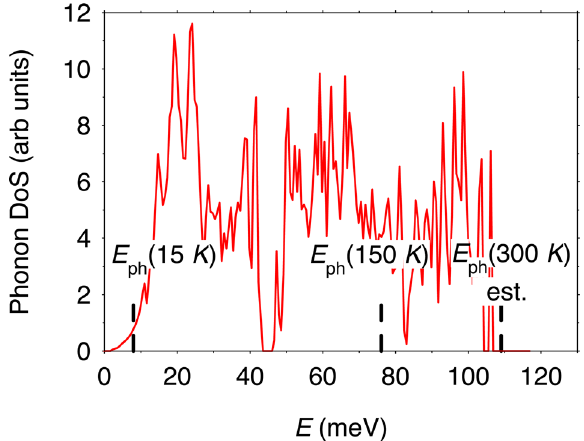
Fig. 7 Theoretical phonon density of states for In 2 O 3 and effective phonon energies at 15, 150, and 300 K. Solid red line: phonon density of states (DoS) for perfect-crystal In 2 O 3 calculated by density functional theory (DFT). Vertical dashed lines: effective phonon energy E ph calculated from quantum magnetoconductivity (QMC) at temperatures 15 and 150 K, and estimated at 300 K. Note that the ranges of energies determined by DFT and QMC are quite